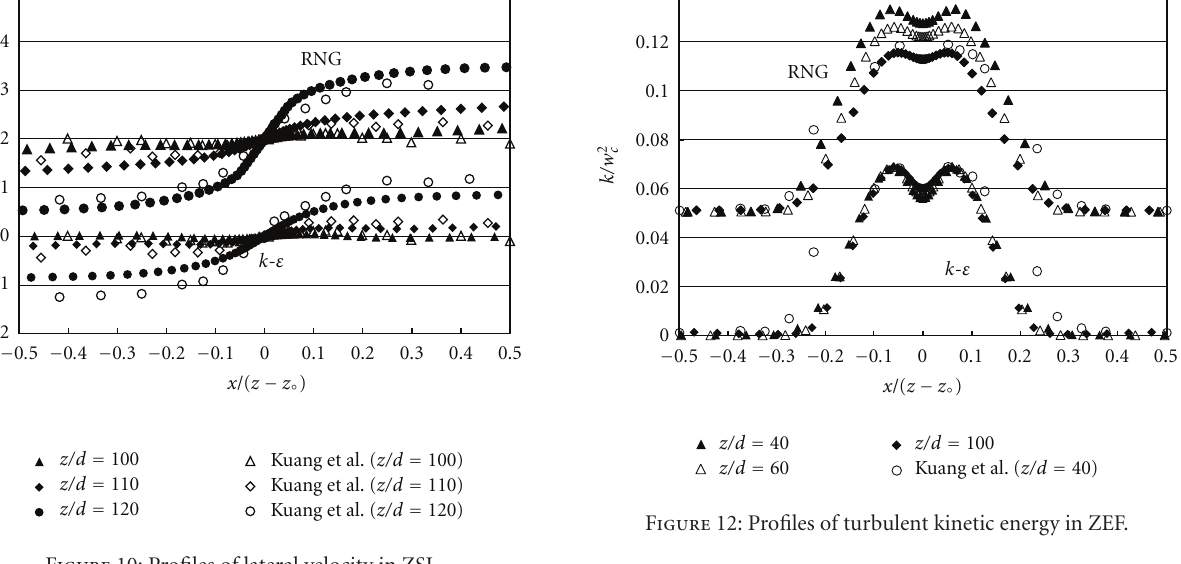
Figure 10: Profiles of lateral velocity in ZSI.